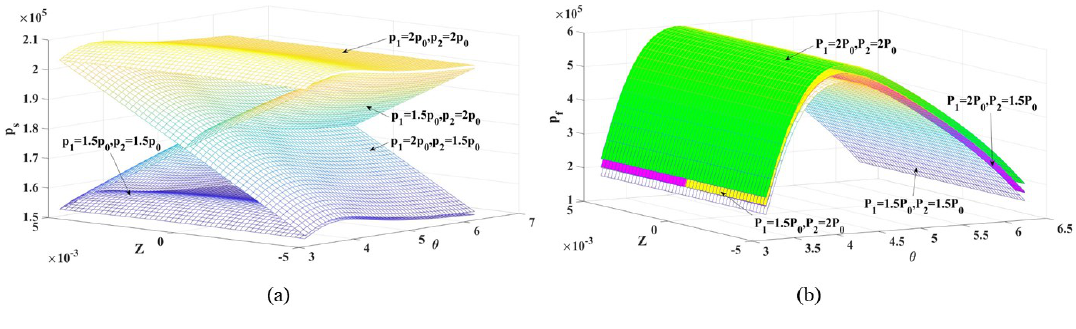
Figure 10. Oil film pressure of end seal on the pressure function. ( a ) Short bearing. ( b ) Finite length